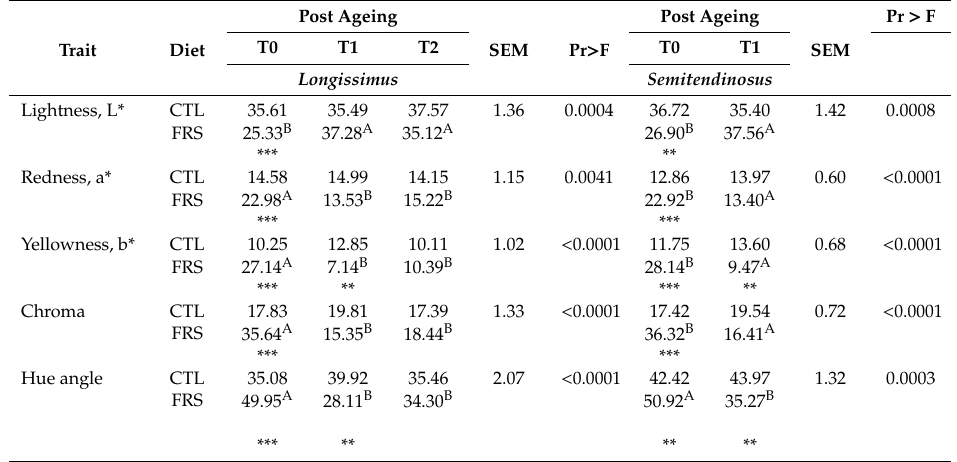
Table 2. E ff ects 1 of interaction feeding system x post ageing time on meat colour in bu ff aloes fed with (FRS; n = 8) or without (CTL; n = 8) rye grass. Mean value and standard error of the mean (SEM). Post Ageing Trait Diet